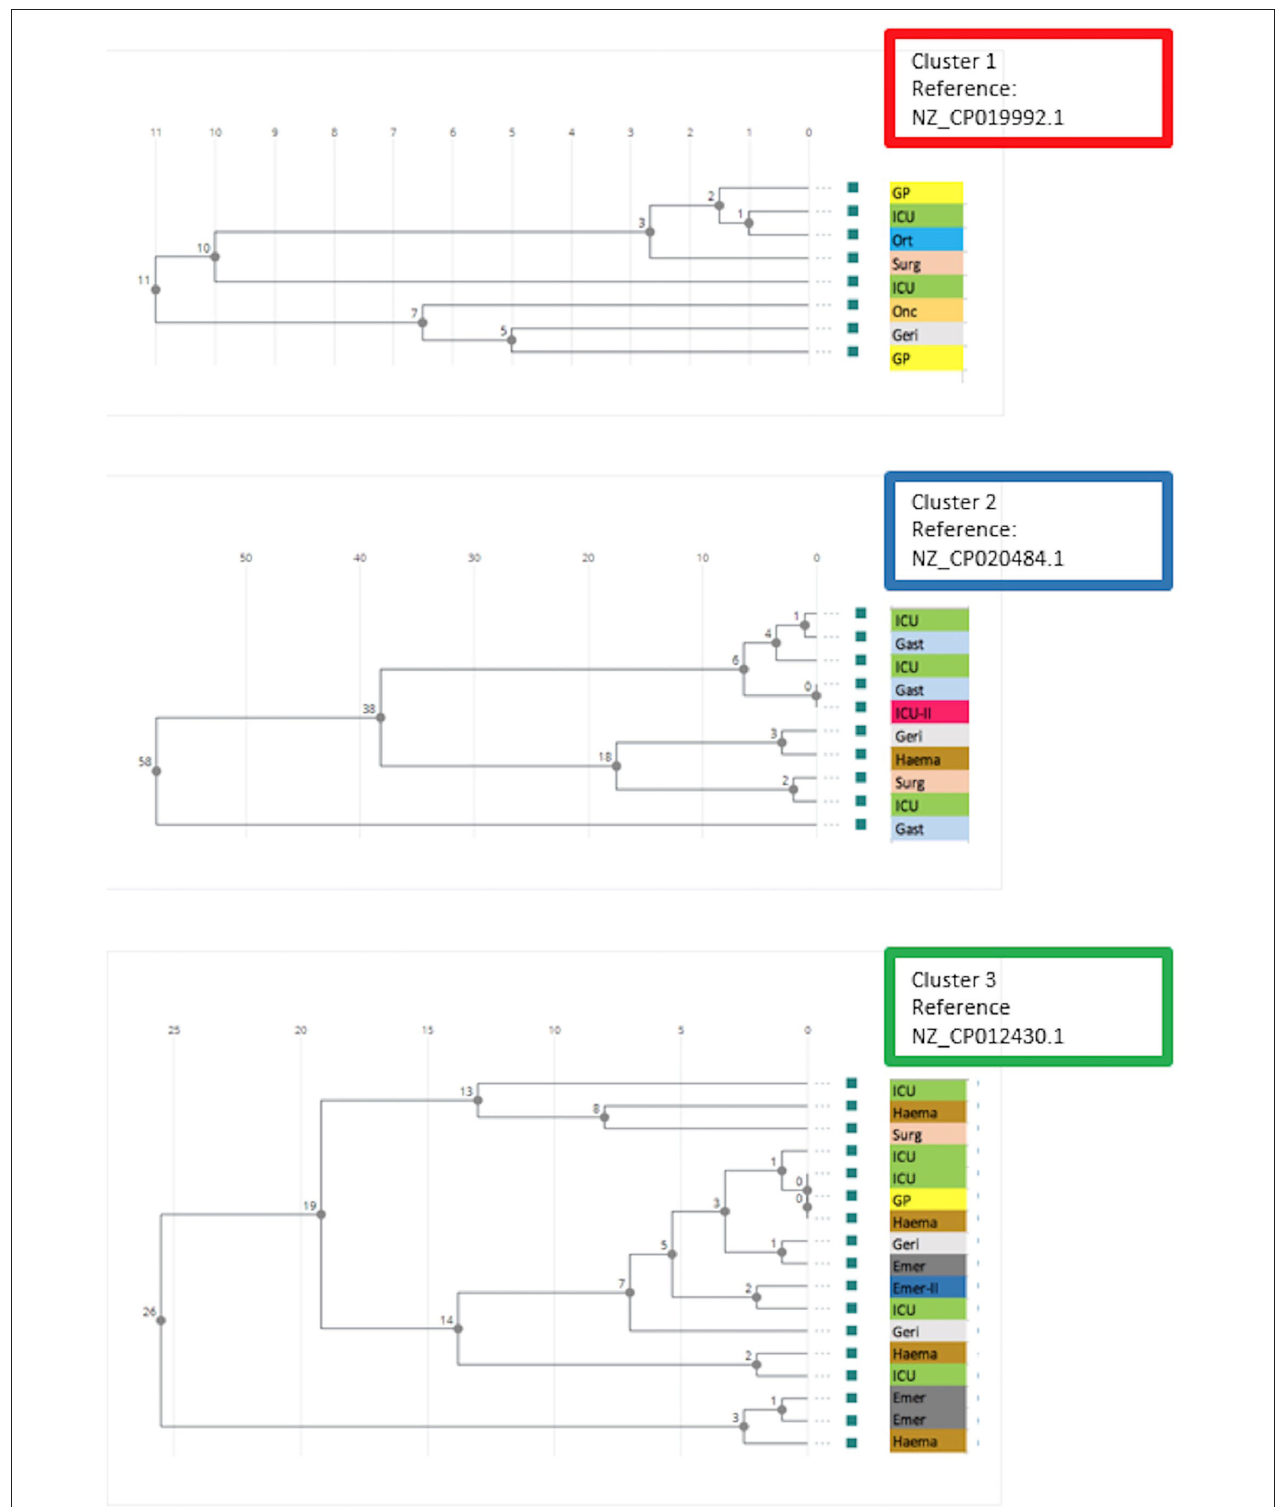
FIGURE 3 | Phylogenetic trees based on SNPs in the core genome of E. faecium carrying vanA gene in the three clusters from Figure 1 . Reference chromosome genome used for the analysis is indicated for each cluster. Location for sampling (General Practitioner or hospital department) is indicated for each isolate. ICU, Intensive Care Unit (hospital location 1); Ort, orthopedic surgery; Surg, abdominal surgery; Onc, oncology; Geri, geriatrics; GP, General Practitioner; Gast, gastroenterology; ICU-II, Intensive Care Unit at second hospital location; Haema, hematology; Emer, emergency; Emer-II, emergency at second location.